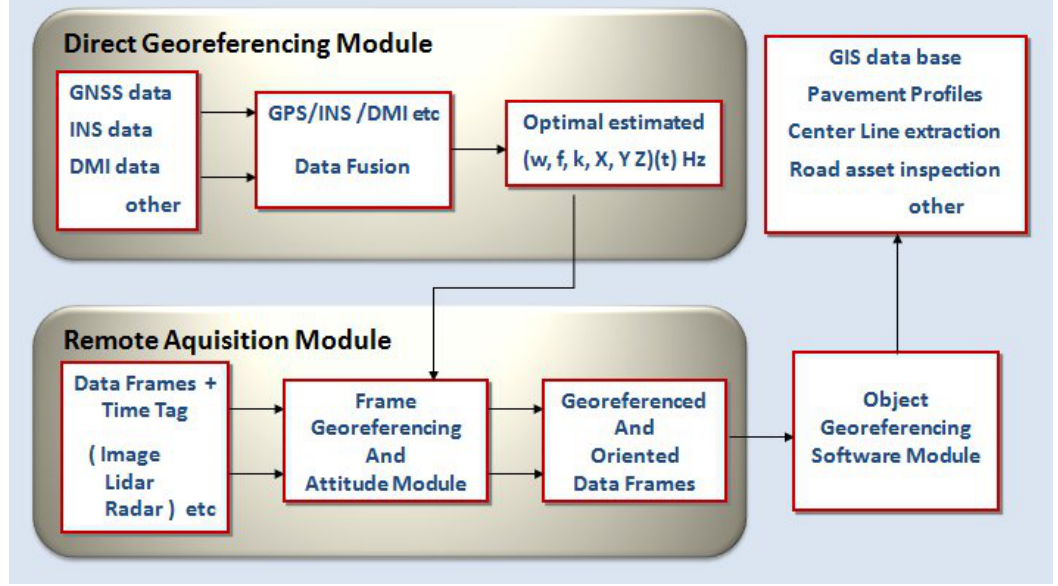
Figure 1. Flow chart of data acquisition and management in a